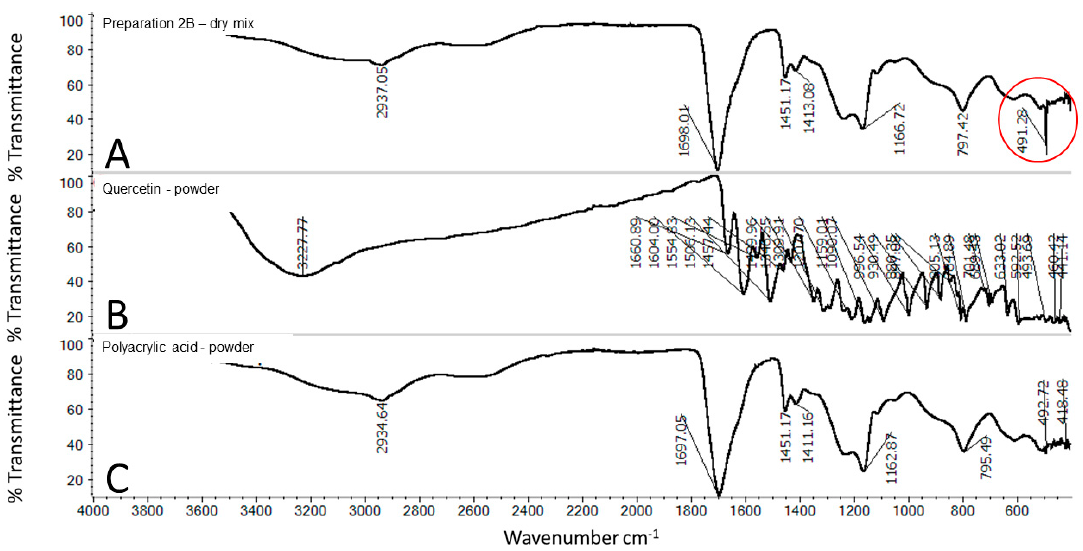
Figure 7. FTIR spectra of: physical mixture ( A ) of quercetin powder and PAA in ratios reflecting the composition of 2B, quercetin ( B ), and PAA ( C